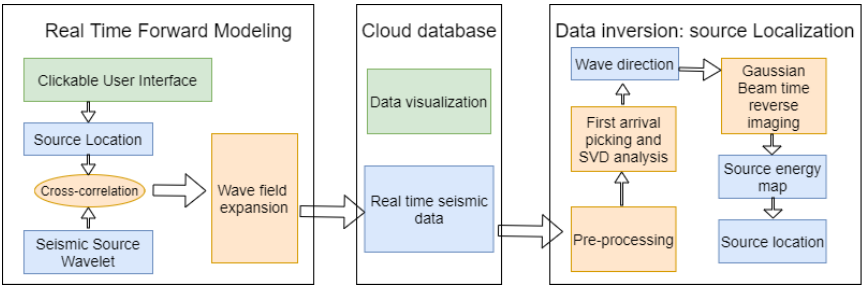
Figure 7. The framework of the real-time microseismic generation and inversion